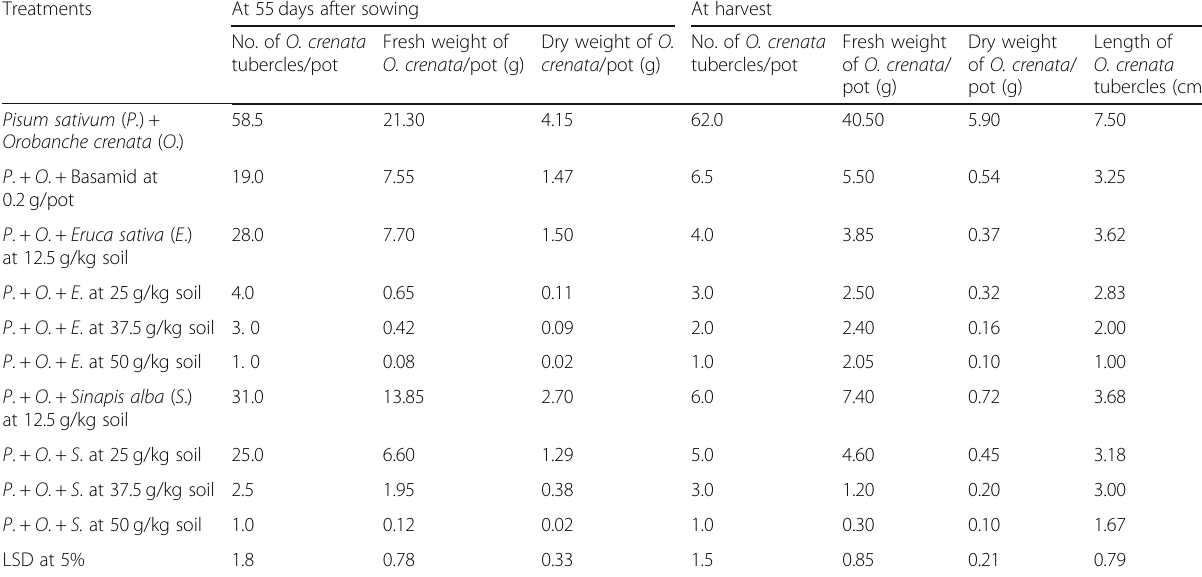
Table 1 Effect of different rates of both Eruca sativa and Sinapis alba seed powder and herbicide Basamid on Orobanche crenata tubercles at 55 days after sowing and at harvest of Pisum sativum (combined analysis of two seasons)